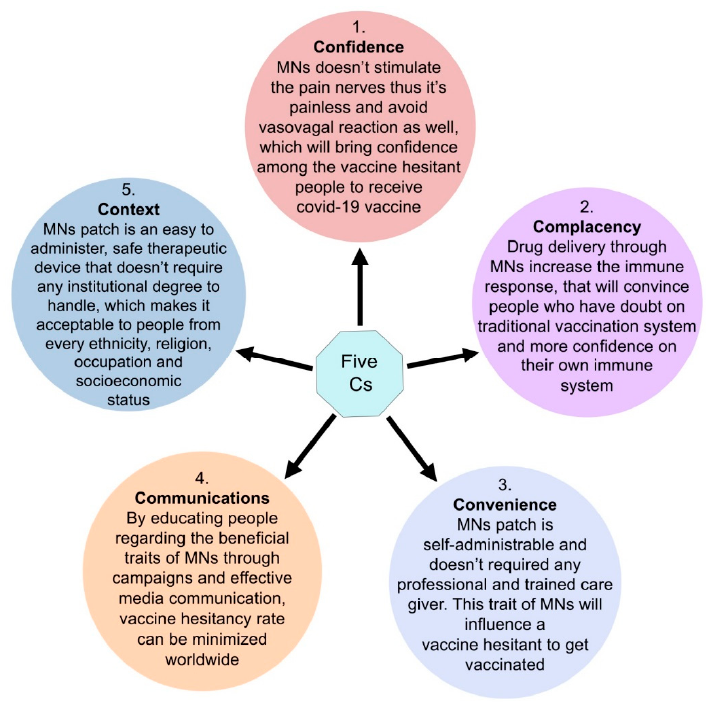
Figure 12. Role of MNs in dealing with vaccine